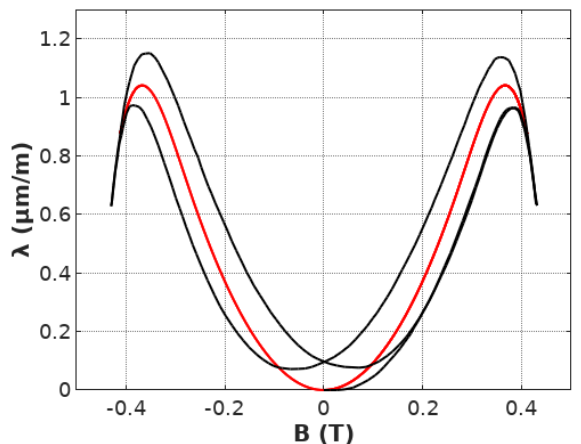
Figure 4. The results of fitting the magnetostrictive anhysteretic curve λ anhyst ( B ) to the results of experimental measurements of λ ( B ) dependence. Identified parameters: a 1 = 9.3 𝜇𝑚 B switch = 0.248 T, k = 0.178.